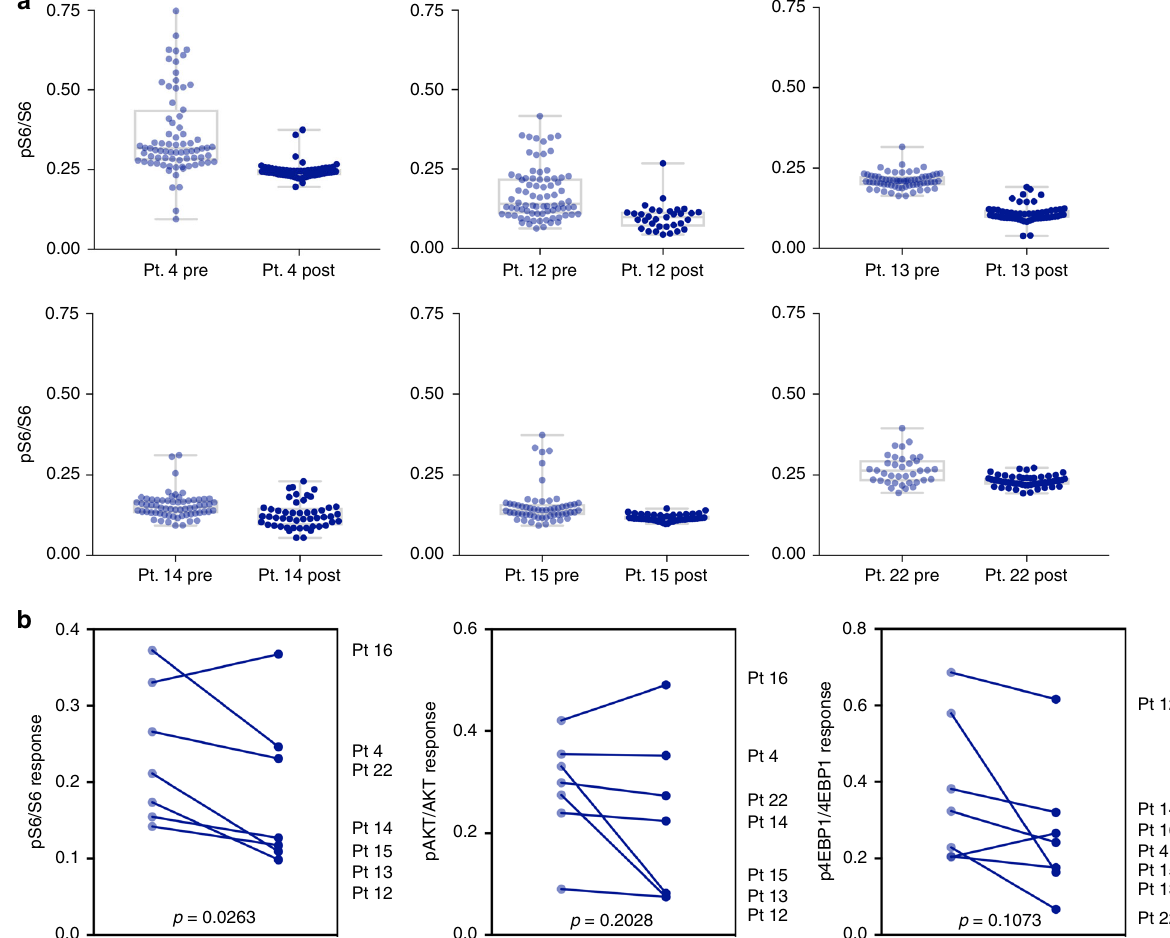
Fig. 7 Patient treatment response. a Single cell analysis of 6 responder patients showing pS6/S6 ratios at baseline (off therapy) and following clinical trial dosing. Pre- and post-treatment single cell values were compared by Mann – Whitney U test ( P < 0.001 for all six samples). b Summarized responses for all analyzed patients before and after treatment for pS6/S6, pAKT/AKT, and p4EBP1/4EBP1 ratios. P -values for the patient sample means were calculated with a ratio paired, 2-tailed T and antibody were measured and used to calculate full pairwise values for the extinction coef fi cient of each species at both 260 and 280 nm. We then derived an